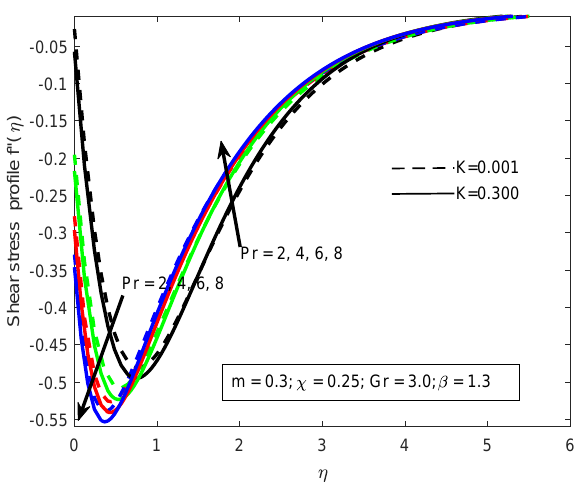
Figure 18: Variation in F (cid:48)(cid:48) ( η ) with P r